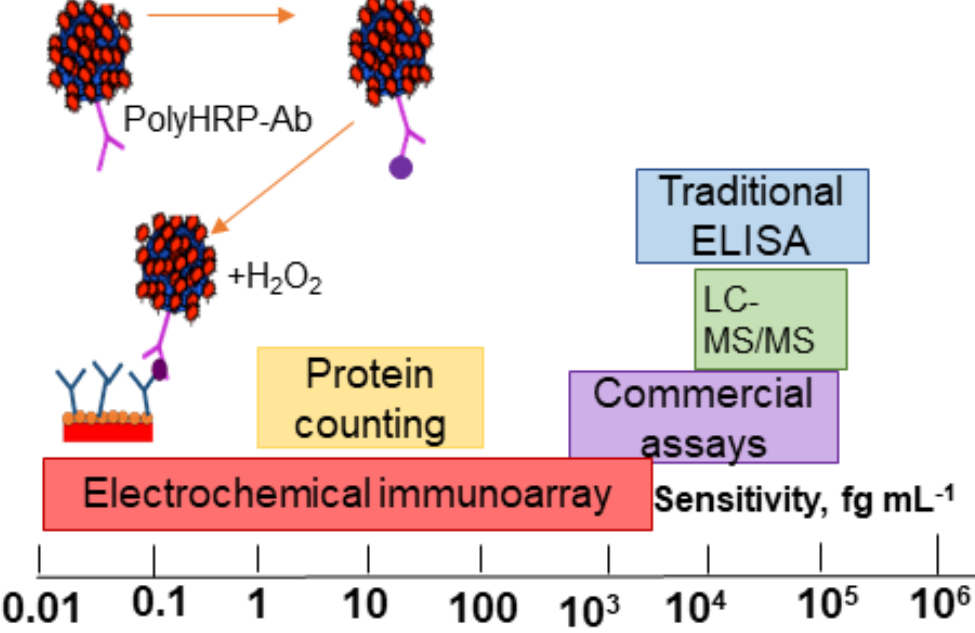
Figure 7. Comparison of the sensitivity of the new electrochemical immunoassay with poly-HRP and AuNP-modified carbon electrodes developed by Dhanapala et al. with other protein detection